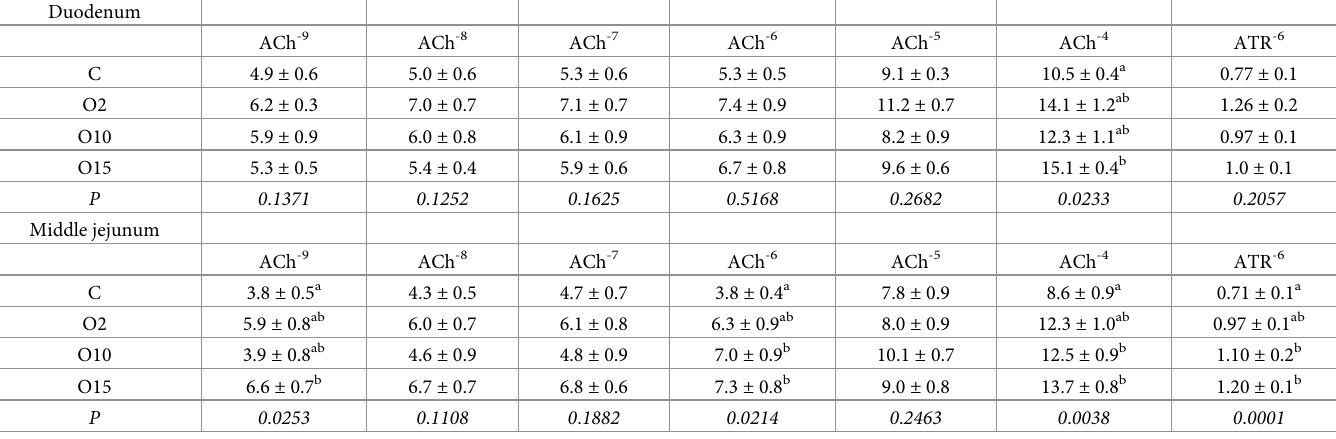
Table 4. The effect of enteral obestatin administration on the amplitude [mm] of acetylcholine chloride (ACh) stimulated or atropine treated contractions in duo- denal and middle jejunum strips from piglets. Duodenum